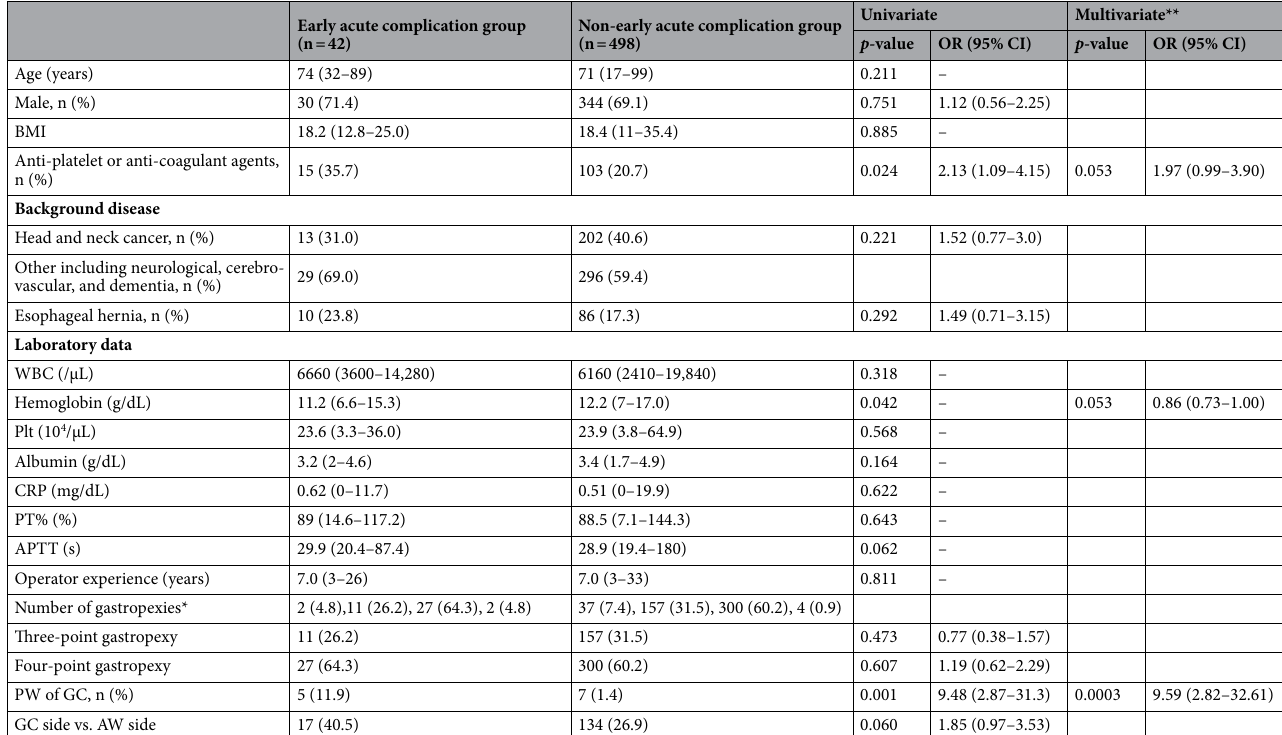
Table 3. Patient background and univariate analysis of early and non-early acute complication groups. Early acute complications were defined as bleeding and perforation. The significance of an association was evaluated using the chi-square test. The Mann–Whitney U-test was employed to analyze continuous variables. APTT activated partial thromboplastin time, AW anterior wall, BMI body mass index, CRP C-reactive protein, GC greater curvature, OR odds ratio, Plt platelet count, PT% prothrombin%, PW posterior wall, WBC white blood cell count. *Two-point fixation, three-point fixation, four-point fixation, and unknown. **In model 1, the three significant univariate analysis factors of anti-platelet or anti-coagulant agents, hemoglobin, and PW of the GC were included for multivariate